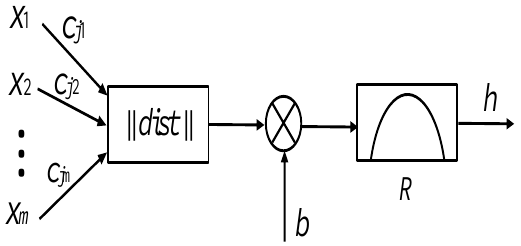
Figure 7. Neuron